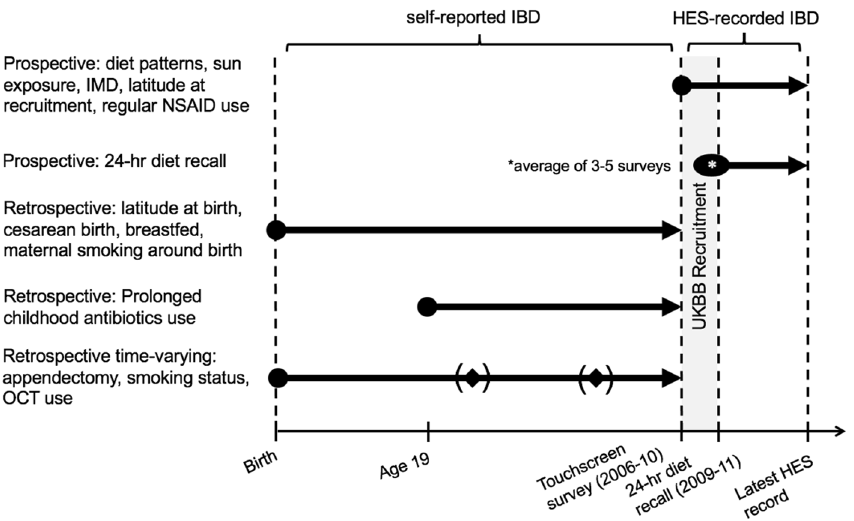
Figure 3. Schematic of the primary analyses we carried out for each variable. All variables were measured at a single time point except 24-h diet recall, which represented the average value from 3 to 5 surveys taken at multiple time points. IBD = inflammatory bowel disease, IMD = Index of Multiple Deprivation (a measure of socioeconomic status), OCT = oral contraceptive